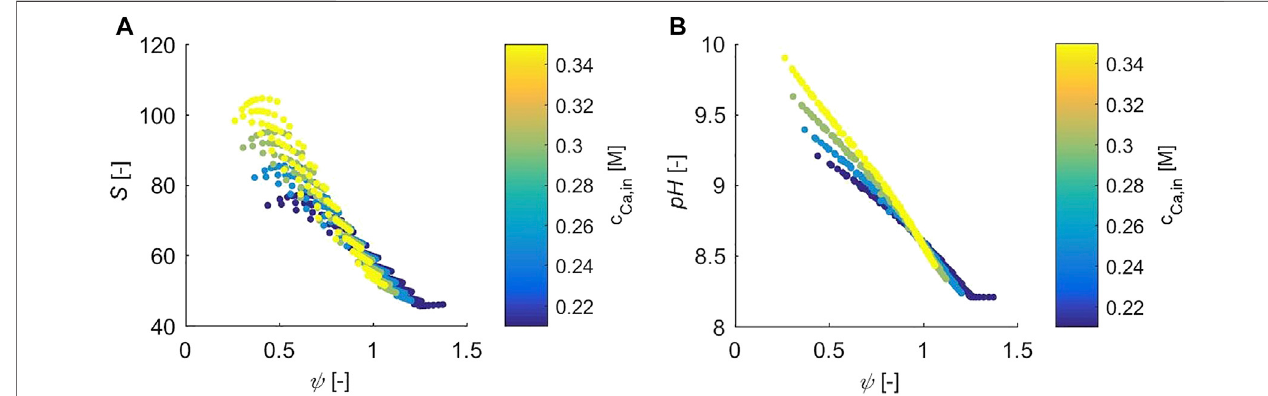
FIGURE 5 | S and the pH are plotted as a function of ψ . The color indicates the calcium concentration. (A) S vs. ψ . (B) pH vs. ψ .